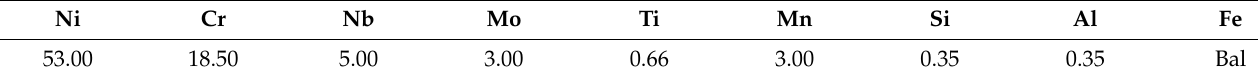
Table 1. IN718 substrate chemical composition (wt.%).